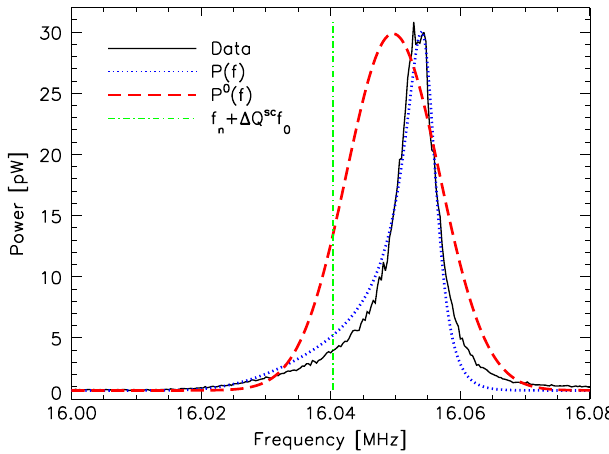
FIG. 9. (Color) Upper vertical sideband of the 75th harmonic measured in SIS-18. The meaning of the curves is the same as in Fig. 8.